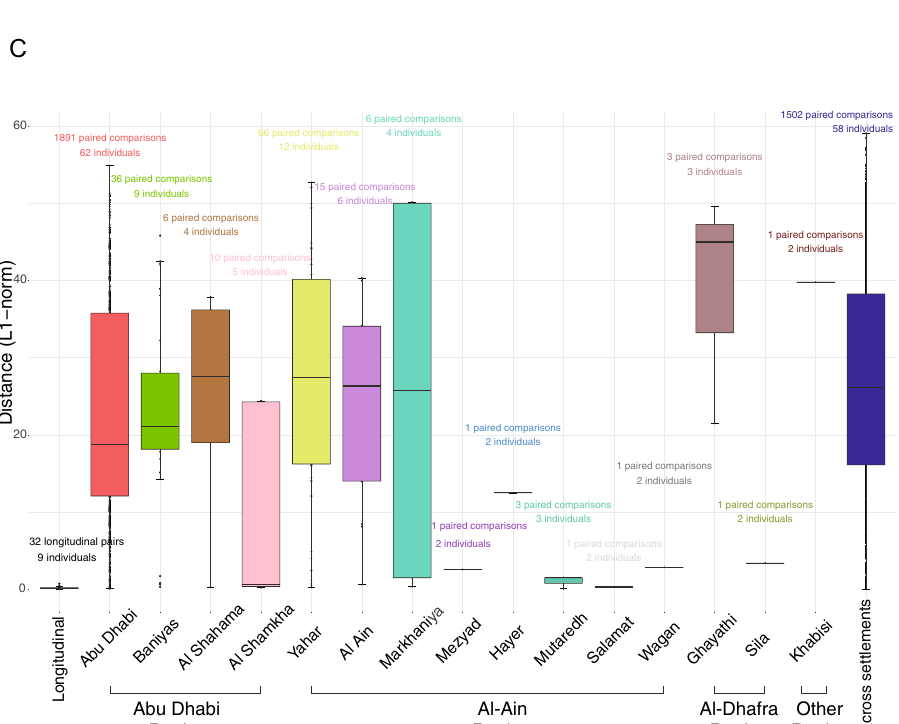
Figure 4. Human-to-human transmission across settlements. ( A ) Geographical distribution of 120 viral samples with settlement level information in the Abu Dhabi city. ( B ) Transmission network of the 120 samples colored by settlements. ( C ) L1-norm genetic distance for longitudinal samples, samples from the same settlements, and samples from different settlements. Among the 130 samples that report settlement level geographical location in Table S5, ten samples were not displayed because only one sample were collected from that settlement. The UAE map was obtained from the world-geo.js file (https:// gist. githu buser conte nt. com/ munaf- zz/ 46302 18/ raw/ 32a38 9a88f 990e0 1c2c7 661c5 51c84 af9ed a1a26/ world- geo. js) and plotted using jQuery JavaScript Library v1.11.1 and echart